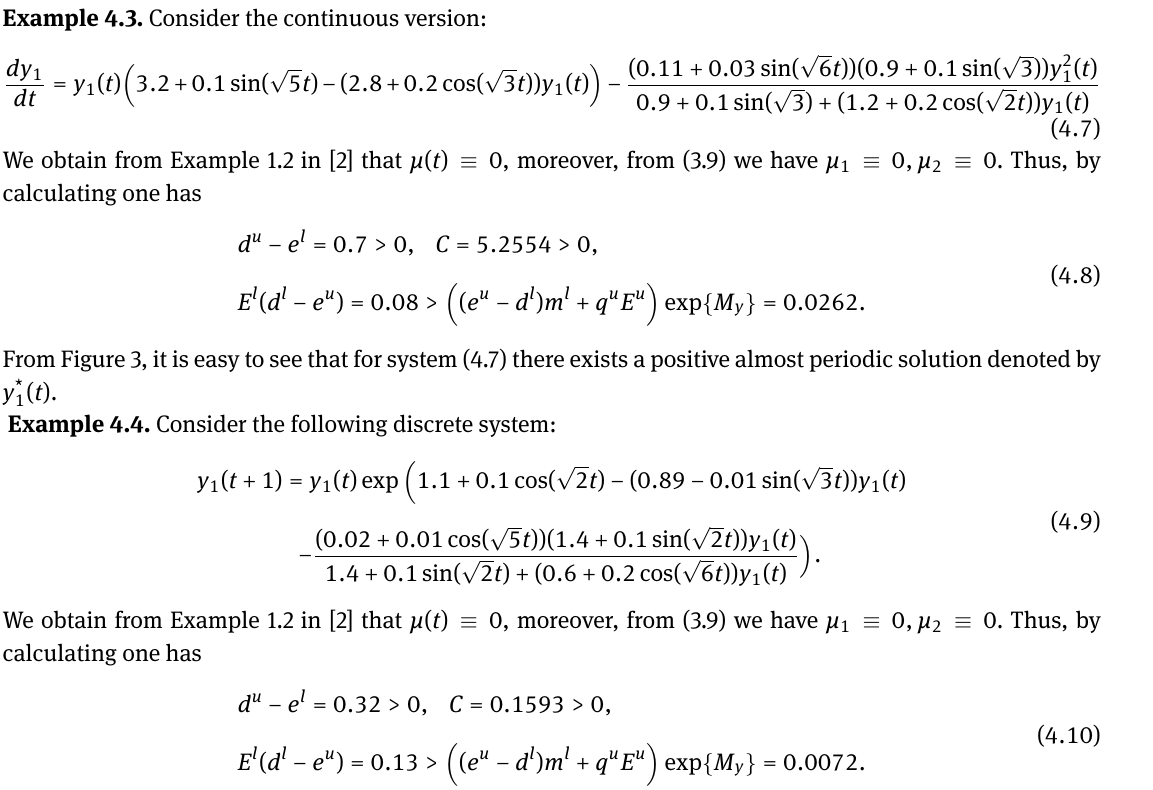
(0) = 1.5, 1 and 0.5 , 1